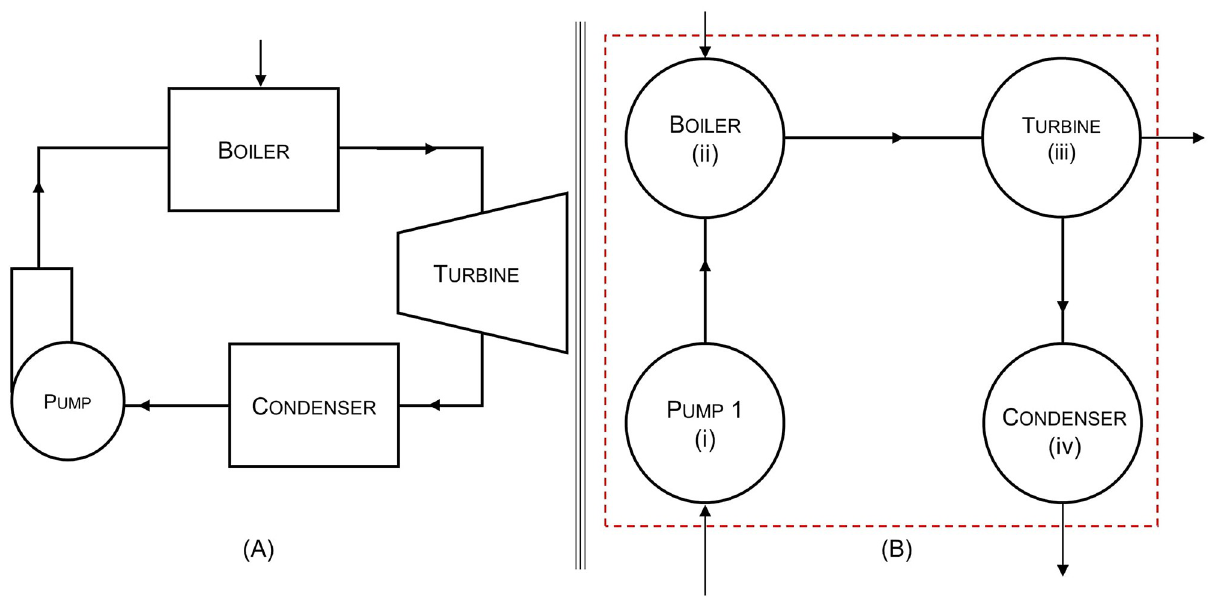
Fig 1. (A) An idealized equipment diagram and (B) A node diagram for the simple Rankine cycle. The red dotted square indicates the system boundary.